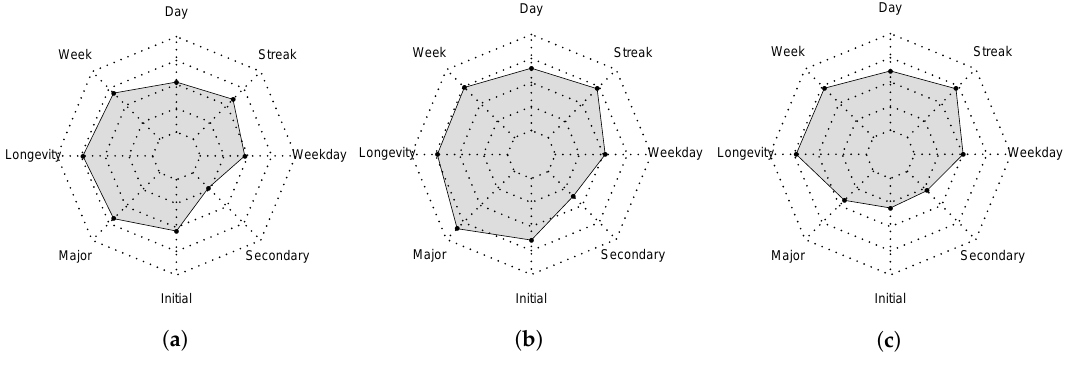
Figure 6. Percentages of the occurrence for each behavior. ( a ) Germany; ( b ) France; ( c ) the United Kingdom.